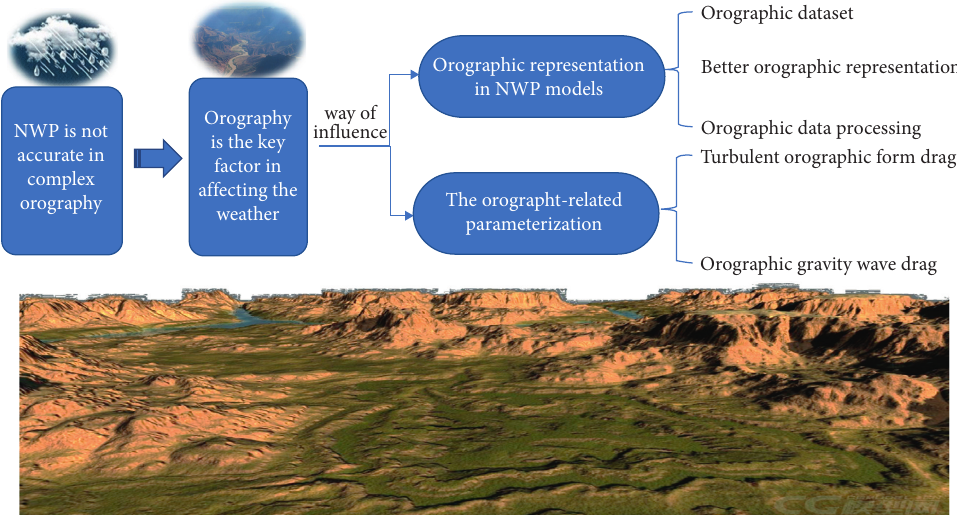
Figure 2: Application of orography in numerical weather